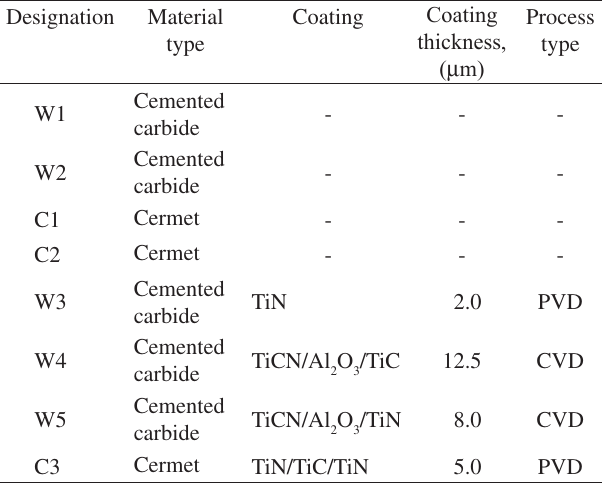
Table 1. Specification of the investigated materials.